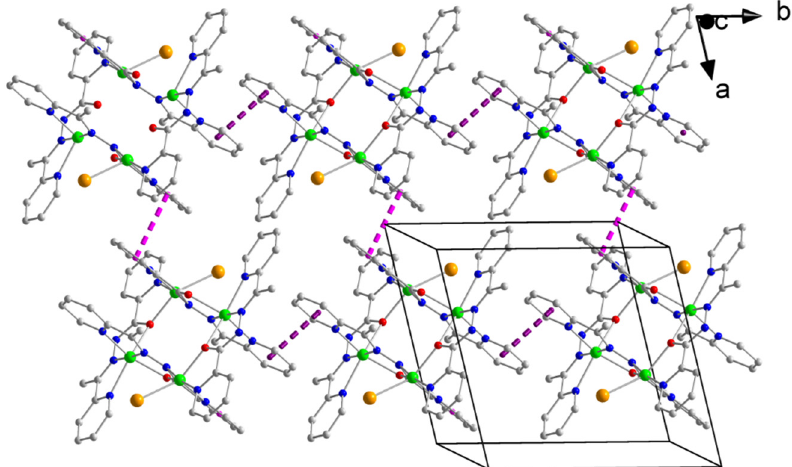
Figure 2. A layer of the tetranuclear cations of complex 1· 0.8H 2 O·MeOH parallel to the (001) plane. The dashed pink and violet lines indicate π – π stacking interactions between centrosymmetrically-related pairs of aromatic rings containing the N1 and N4 atoms, respectively.